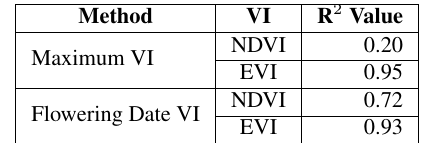
Table 5: Regression for yield with maximum VI and flowering date VI